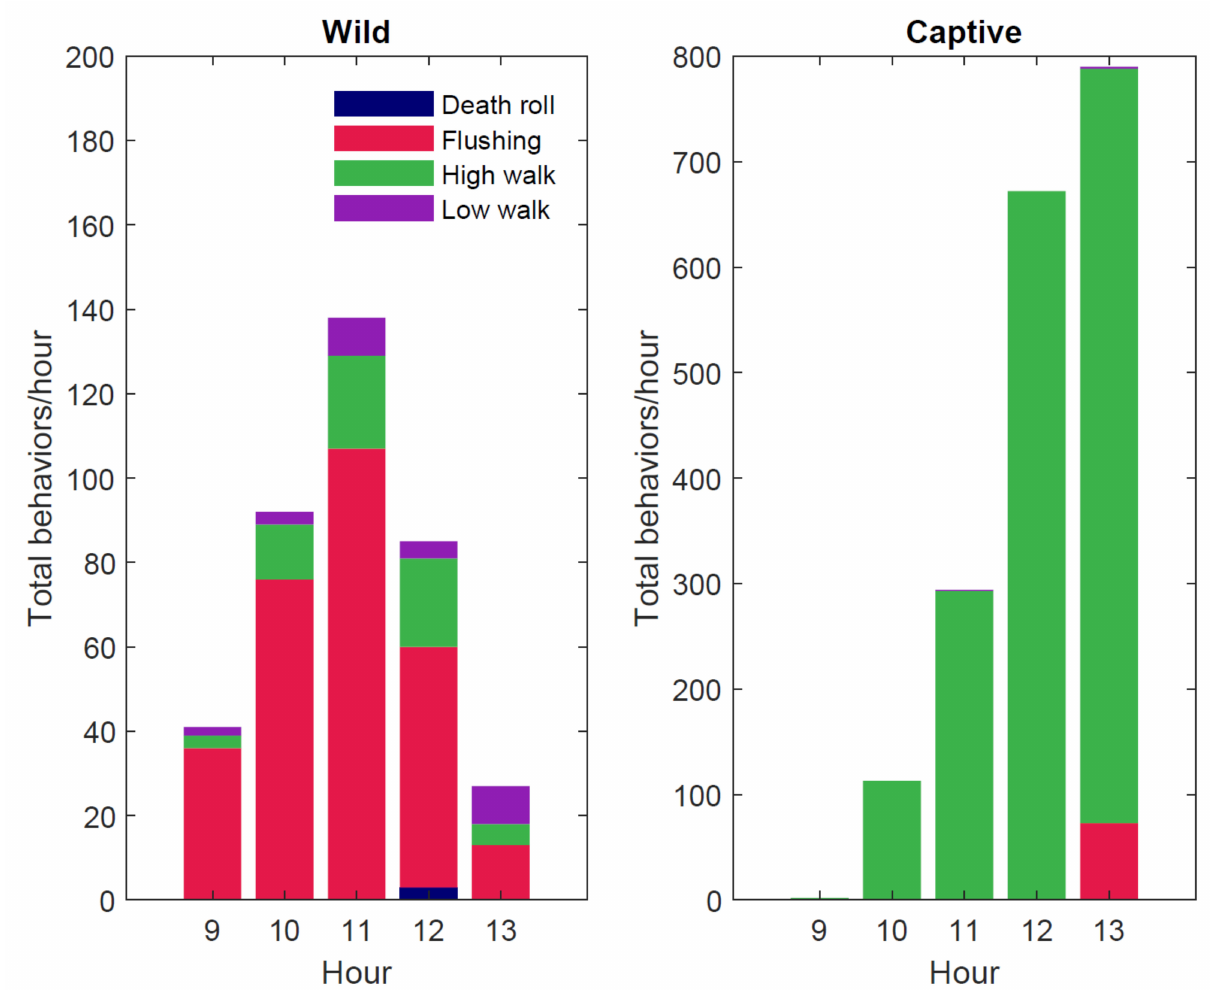
Figure 5. The total number of specific general behaviors (color-coded) during each hour of the day summed across days. The general behavior of the wild congregation is represented in the left plot and the general behavior of the captive congregation in the right plot. Note that the y -axis limits are different between the wild and captive congregation plots. Feeding is excluded because food offerings only occur between 11:30 and 13:27 in the captive congregation, whereas in the wild feeding may occur at any